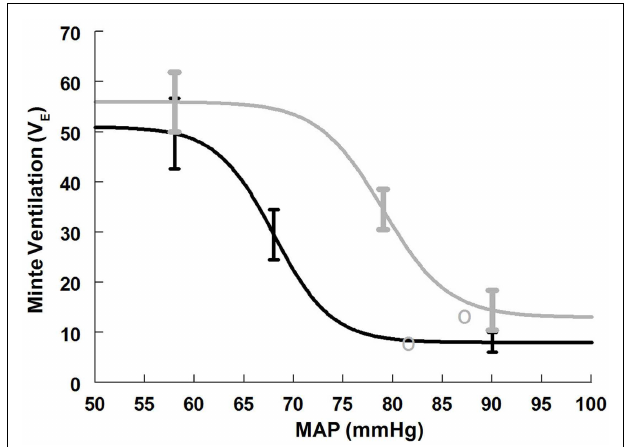
FIGURE 4 | Supine and upright ventilatory baroreflex relationships were obtained by averaging data-fits over all subjects during the Oxford maneuver. The upright curve is shifted to the right from supine but the maximum slope (sensitivity) is unaffected by posture.